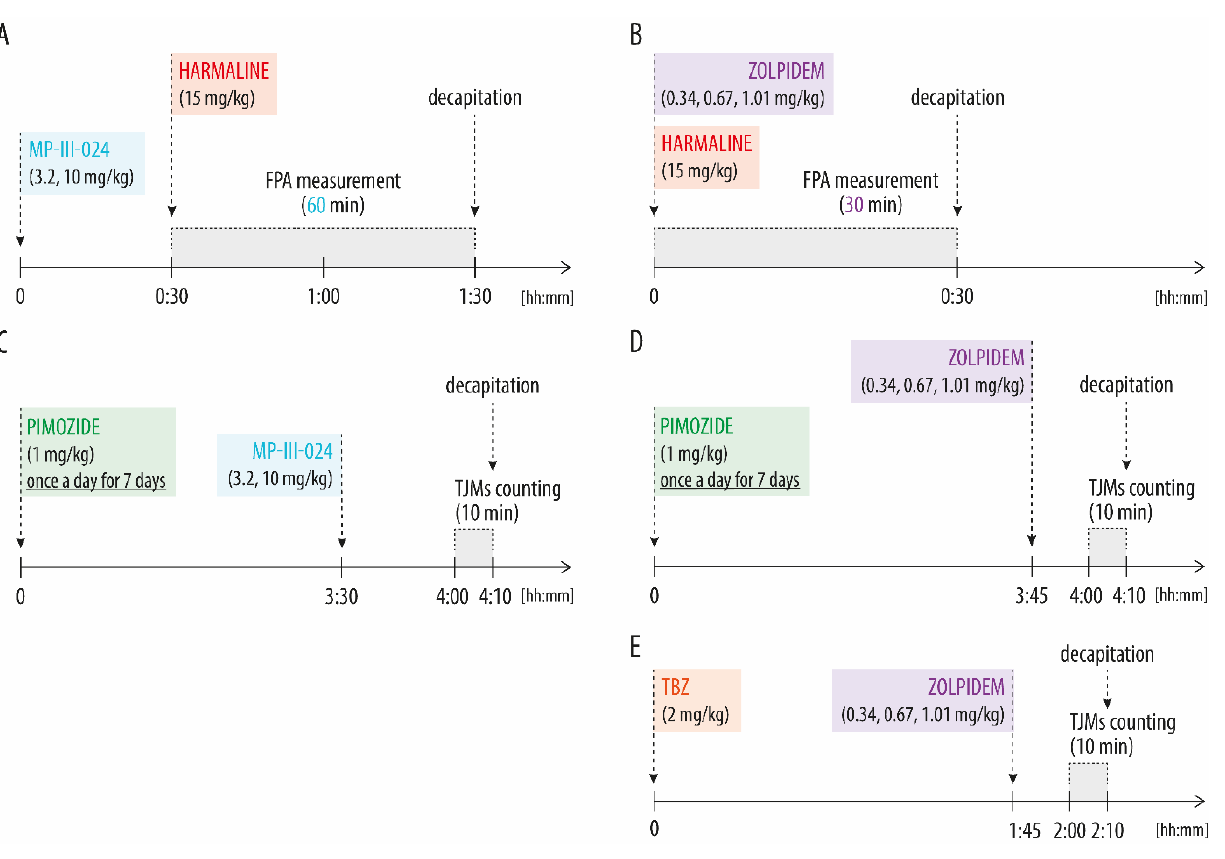
Figure 1. Timelines of drug administration and harmaline-induced tremor measurement ( A , B ) or observation and counting of TJMs induced by pimozide ( C , D ) or TBZ ( E ). FPA measurement of harmaline-induced tremor lasted 30 min or 60 min for experiments with zolpidem and MP-III-024, respectively. Abbreviations: FPA—Force Plate Actimeter; TBZ—tetrabenazine; TJMs—Tremulous Jaw Movements.